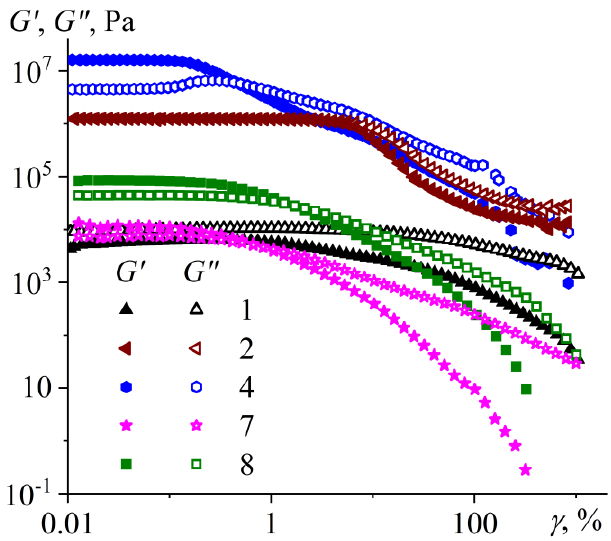
Figure 9. Typical dependences of storage ( G ′ ) and loss ( G″ ) moduli on strain amplitude ( γ ) for bitumens at 25 °C.